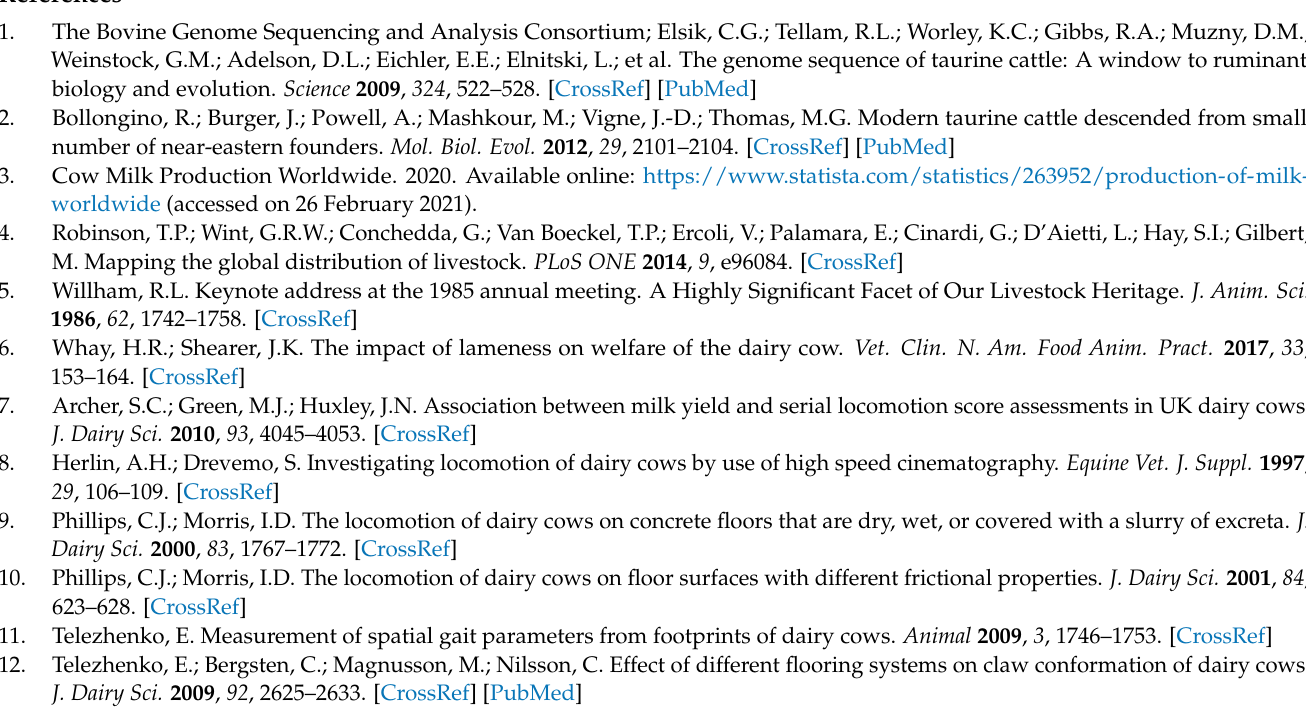
Figure S2. Posture parameters for concrete surface (soak factor); Figure S3. Posture parameters for rubber surface (friction factor); Figure S4. Kinematics parameters for rubber (friction factor) and concrete (soak factor) surfaces; Figure S5. Behavior parameters for rubber and concrete surfaces; Figure S6. Behavior parameters for sand and rubber surfaces; Figure S7. Kinematics parameters for sand, rubber and concrete surfaces; Figure S8. Kinetics parameters for rubber, asphalt and concrete surfaces; Figure S9. Kinematics parameters for rubber, asphalt and concrete (soak factor) surfaces; Figure S10. Behavior parameters for sand and rubber surfaces; Figure S11. Kinematics and Kinetics parameters for grass, rubber and asphalt surfaces; Figure S12. Kinematics parameters for rubber, asphalt and concrete